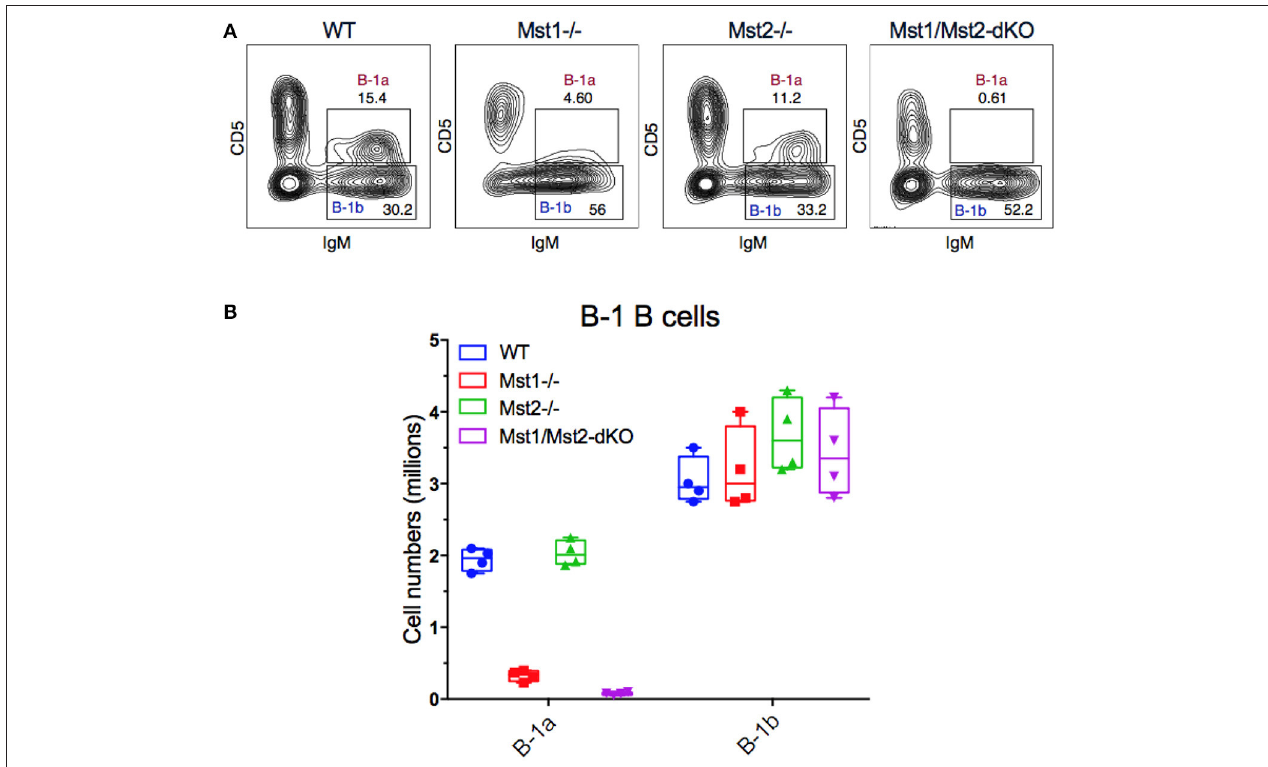
FIGURE 6 | Loss of the B-1a B cell compartment in Mst1 − / − and Mst1/Mst2-dKO mice. (A) Flow cytometric analysis show a reduction of the CD5 + IgM + B-1a B cell compartment in the peritoneal cavity of Mst1 − / − and Mst1/Mst2-dKO mice. The B-1b B cell compartment in Mst2 − / − is intact. (Data are representative of 4 mice analyzed for each group). (B) Absolute cell counts of B-1a and B-1b B cell subsets in the peritoneal cavity of WT and mutant mice. (Box plots represent mean ± SE, n =